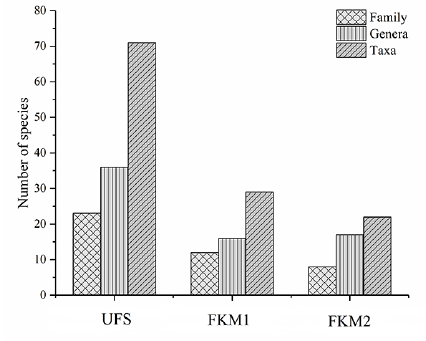
Figure 3 Diversity of bryophytes in forest enclosed within the sinkhole (UFS) and in the two open forests (FKM1 and FKM2) on the plateau